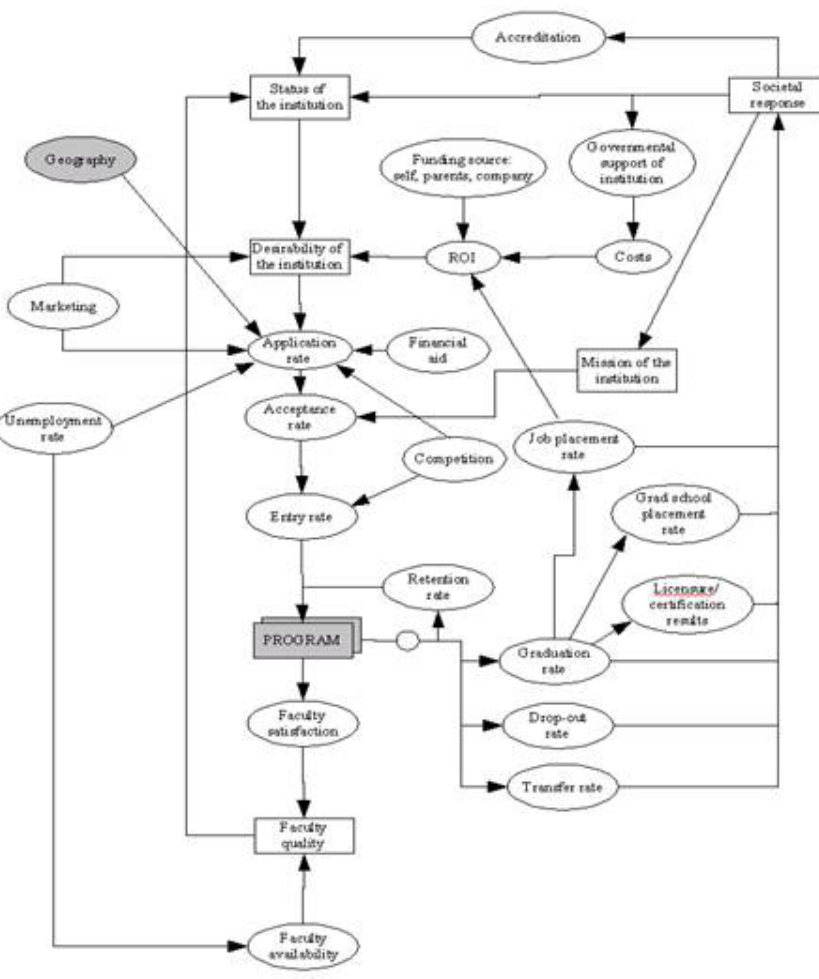
Figure 4. Preliminary model of the socio-economic environment of